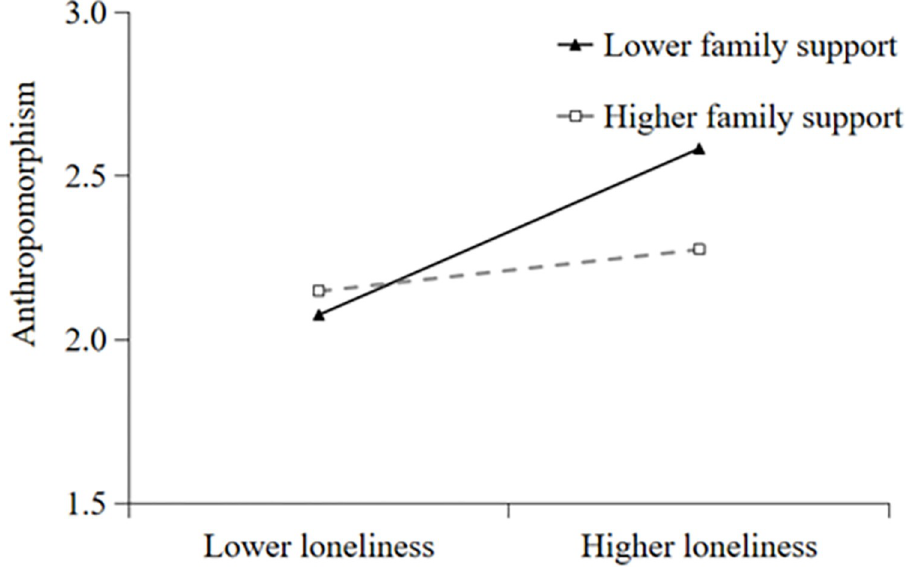
Fig 3. Family support moderates the relation between loneliness and